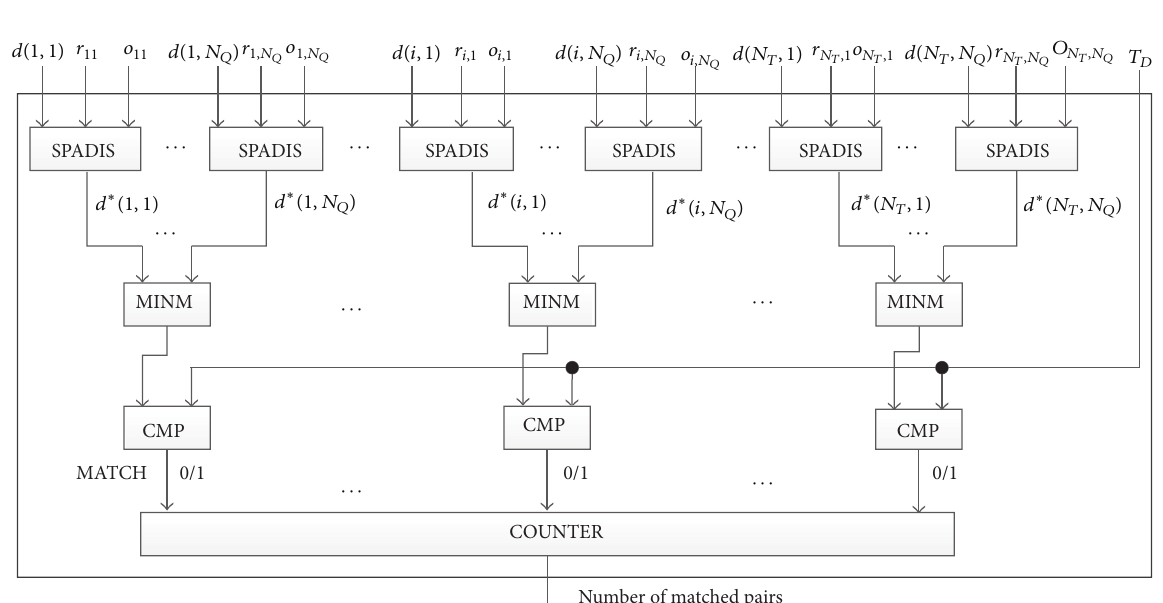
Figure 2: Finding matched minutiae and counting their number.